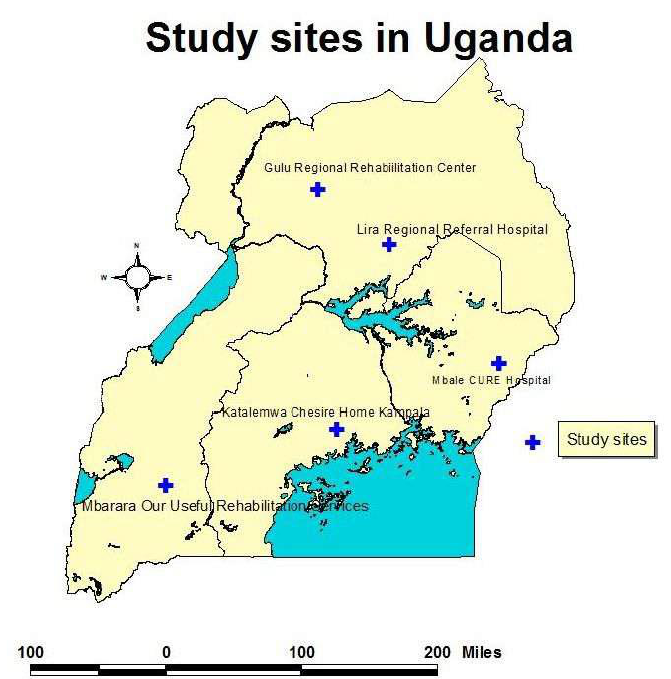
Figure 1. Map study